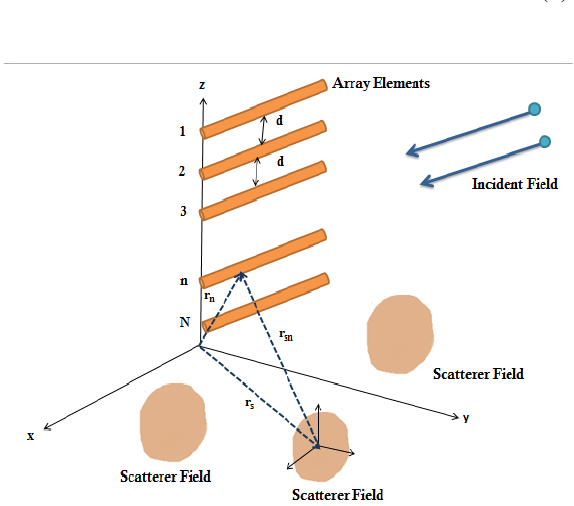
Figure 1: Incident Plane wave on N -element antenna array with arbitrary shaped near-zone Scatterer. Field at any antenna element is sum of both incident plane wave and the scattered waves.